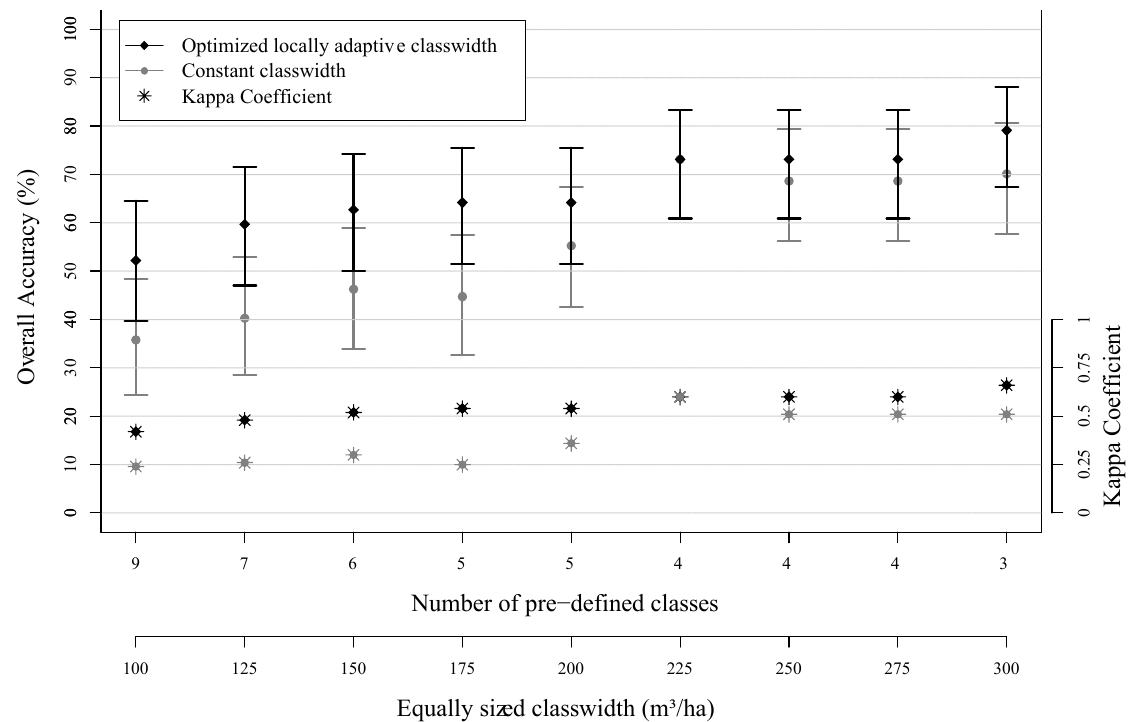
Figure 6. Overall accuracies with 95% confidence intervals and corresponding kappa coefficients for a pre-defined number of classes, calculated for constant and locally-adapted class